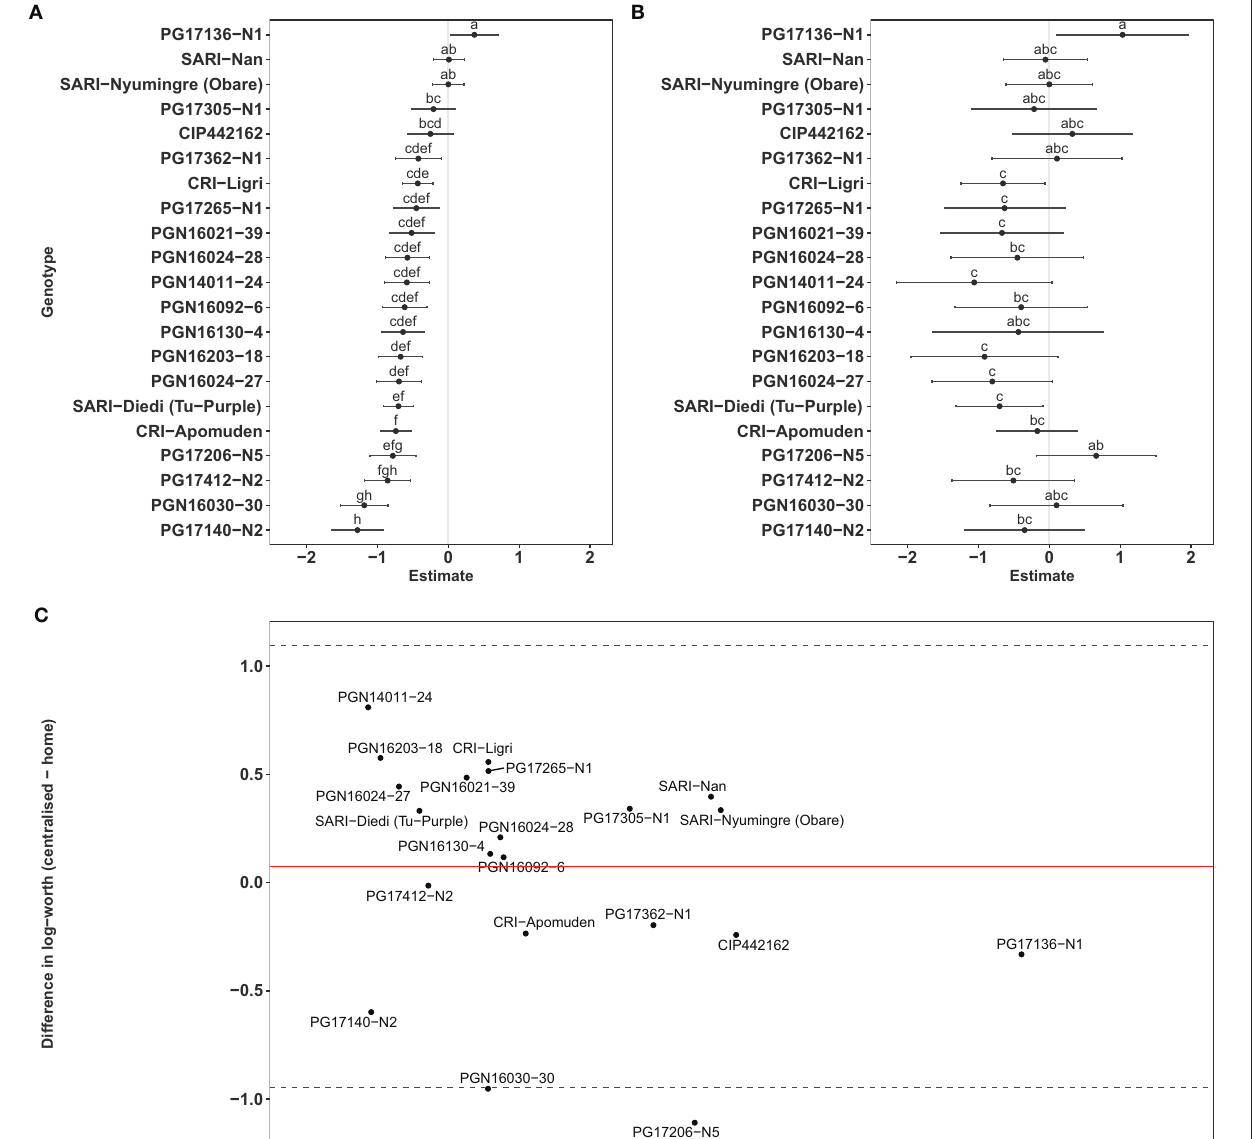
The second-preferred genotype was different for each trial. In the centralized trial, Kakamega, NASPOT 8 (the reference) and NASPOT 13 had statistically similar performance. In contrast, in the home trial, NASPOT 13 outperformed the reference for second rank. Figure 5C shows the difference in model estimates between the two trials as a comparison for their